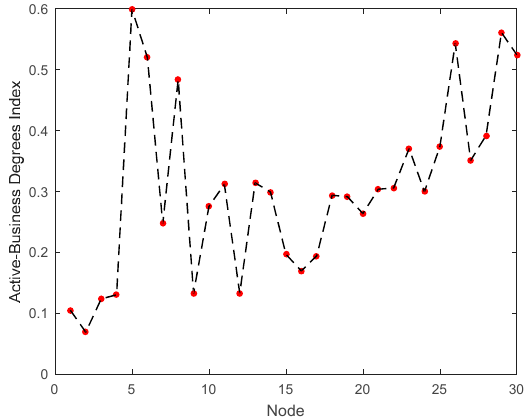
Figure 9. Active-business degrees index.